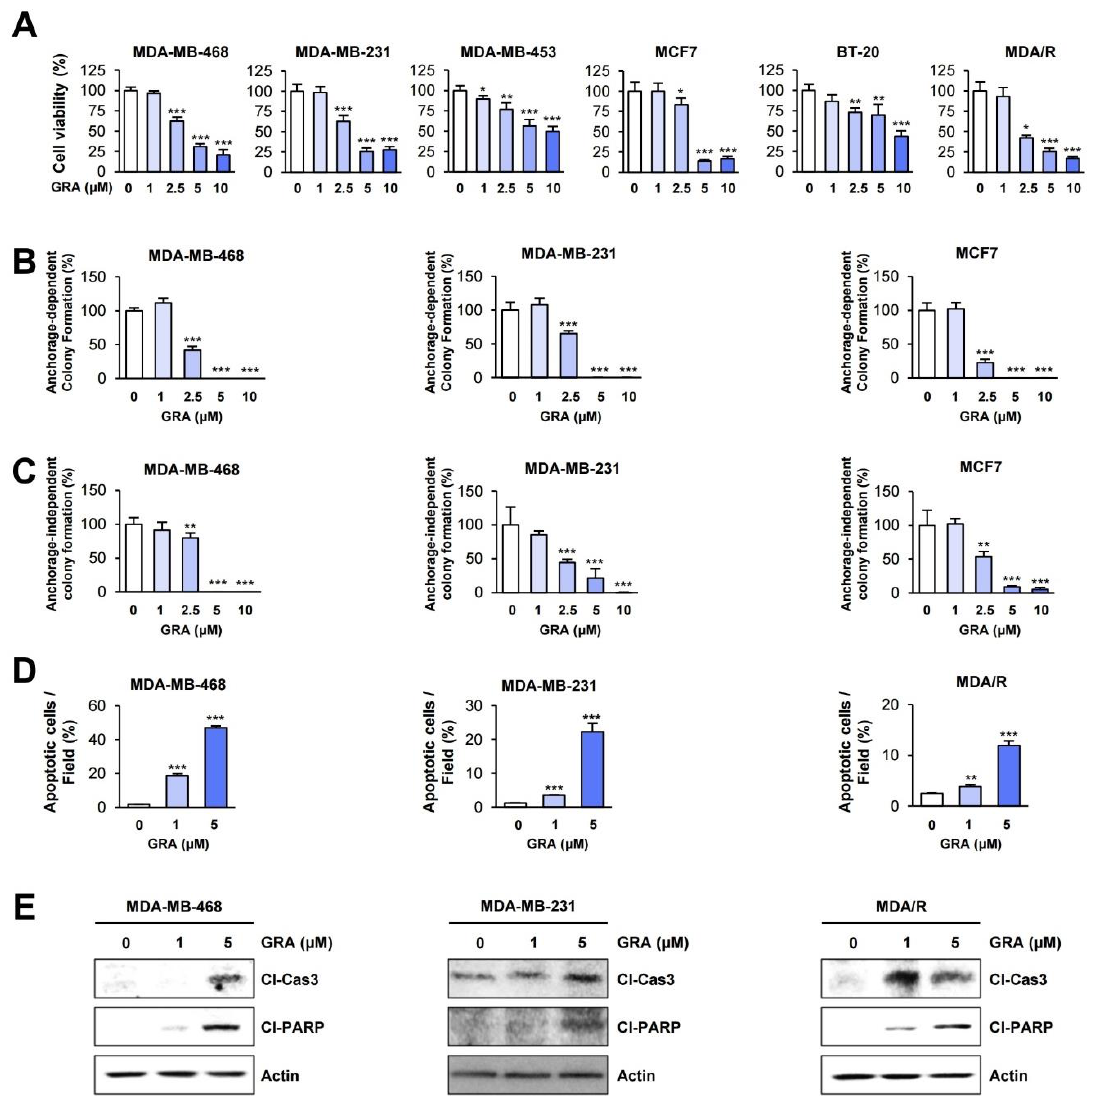
Figure 3. Gracillin exerts inhibitory e ff ects on the viability and colony formation of breast cancer cells by inducing apoptosis. ( A ) The e ff ects of gracillin on the viability of breast cancer cells were determined by crystal violet assay. ( B , C ) The e ff ects of gracillin on the colony formation of breast cancer cells were determined by anchorage-dependent colony formation assay (B) and soft agar colony formation assay ( C ). ( D , E ) The proapoptotic e ff ects of gracillin were determined by the analysis of Hoechst 33342-stained cells ( D ) and Western blot ( E ). The bars represent the mean ± SD; * p < 0.05, ** p < 0.01, and *** p < 0.001, as determined by a two-tailed Student’s t -test by comparison with